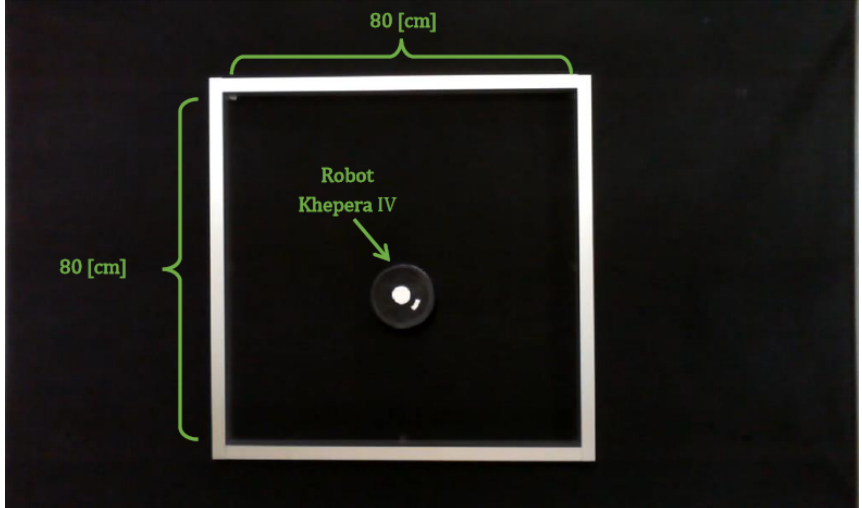
Figure 8. Set up of the workspace.